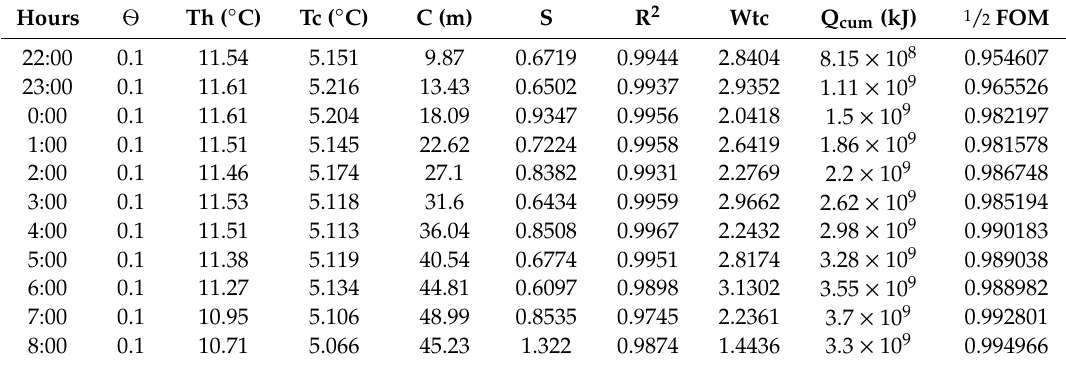
Table A4. 4th–5th January 2019 Curve Fitting and Performance Parameter analysis.